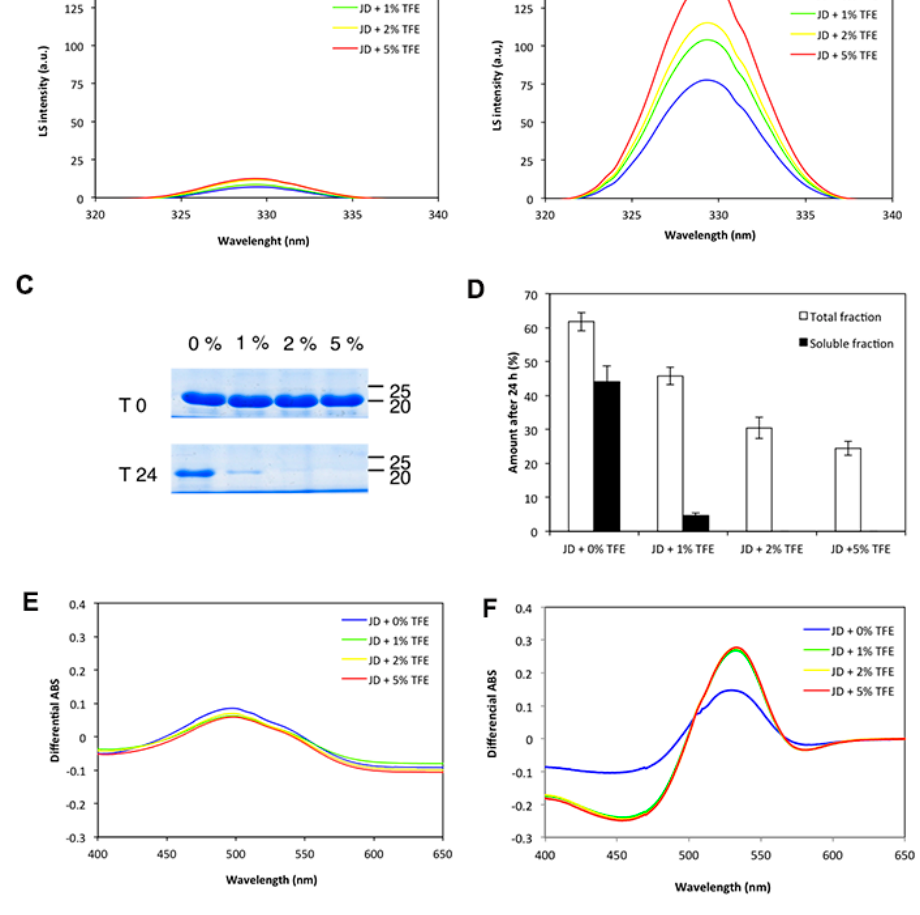
Figure 7. TFE-induced aggregation of JD after a 24-h incubation at 37 °C at the indicated concentrations of the osmolyte ( v / v ), as assessed by different spectral measurements. Light scattering of 80 µM freshly prepared ( A ) JD and after 24 h of incubation ( B ) in the presence of 0%, 1%, 2% and 5% TFE ( v / v ); ( C ) SDS-PAGE of the soluble fraction of JD incubated for 24 h in the presence of 0%, 1%, 2% and 5% ( v / v ) TFE. Gels were stained using the BluSafe Reagent; ( D ) densitometric analysis of SDS-soluble band of total and soluble fraction. Bars represent standard deviations. Congo red binding assay of freshly prepared ( E ) JD and after 24 h of incubation ( F ) in the presence of 0%, 1%, 2% and 5% TFE ( v / v ). Data are represented as differential spectra relative to 0 time. All the measurements were performed at 25 ◦